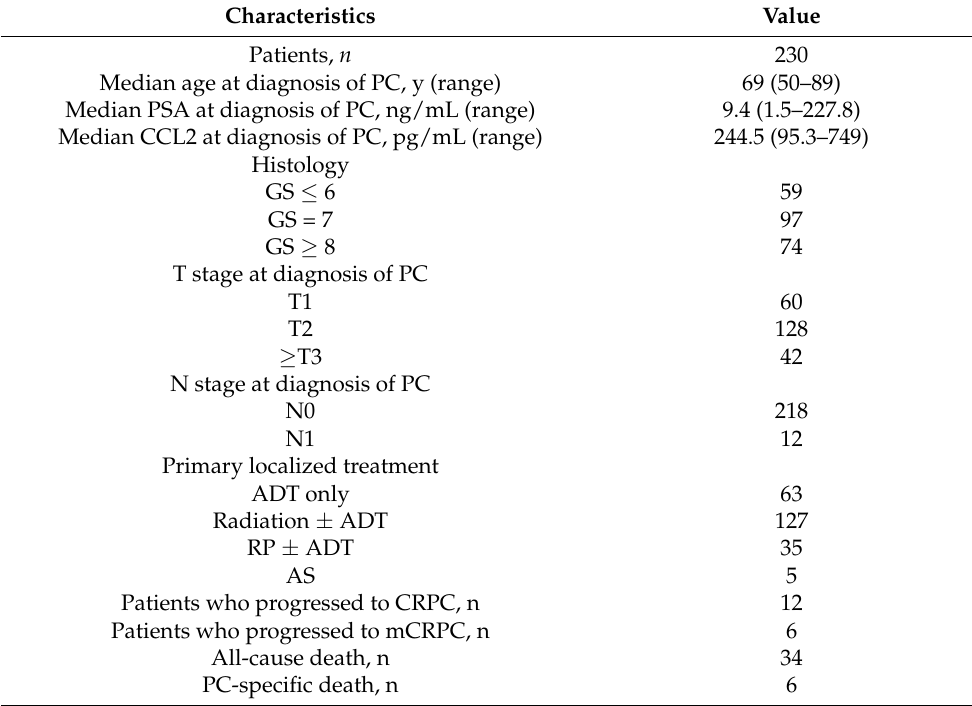
Table 1. Patients’ characteristics.